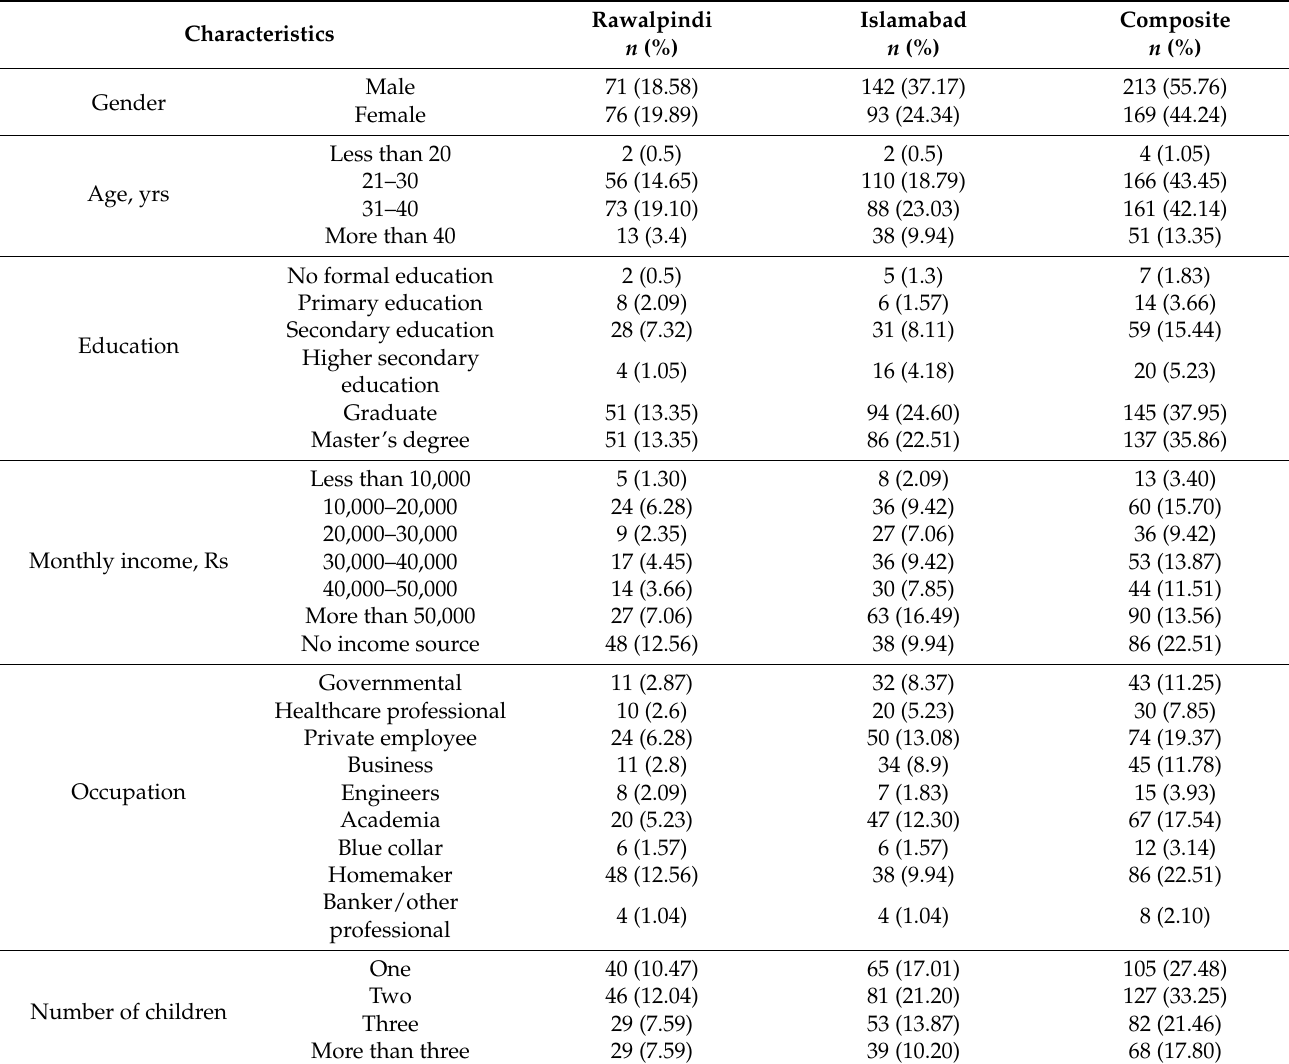
Table 1. Demographic characteristics of the respondents.